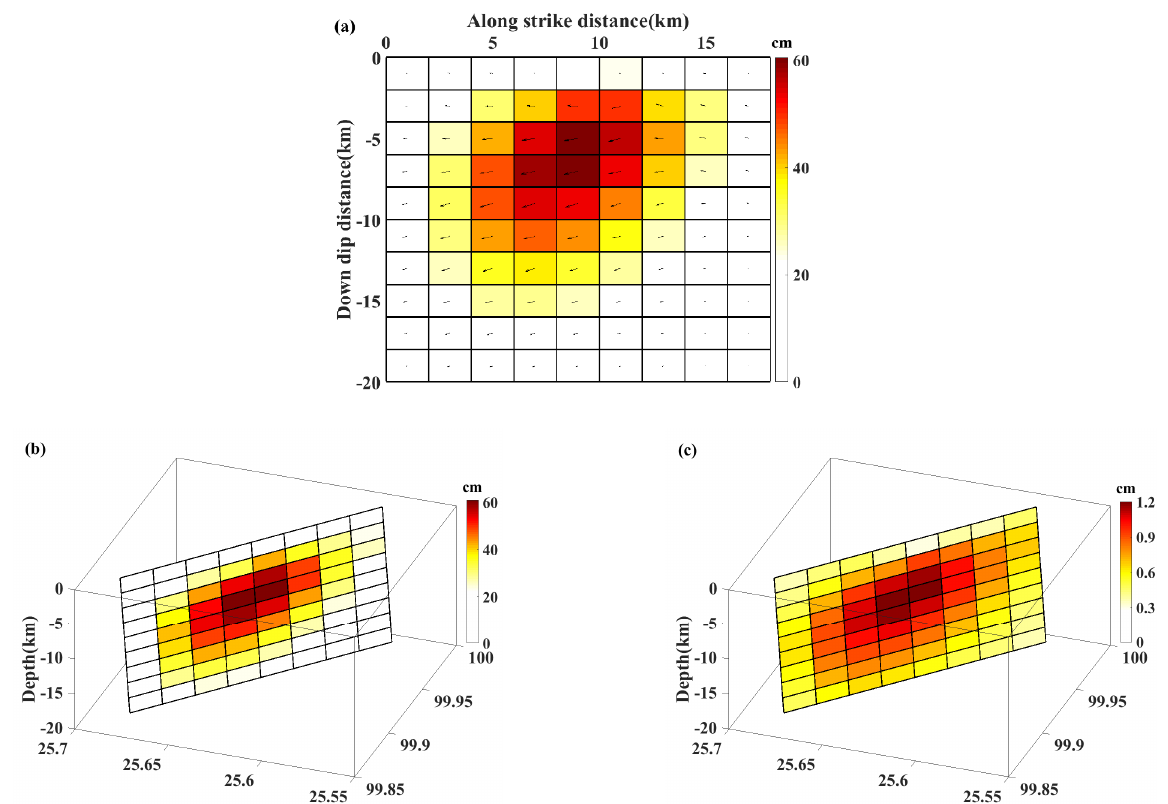
Figure 8. ( a ) Two − dimensional results of fault plane slip; ( b ) Three − dimensional display of fault slip; ( c ) The Monte Carlo estimation of fault slip with 1 σ uncertainty.